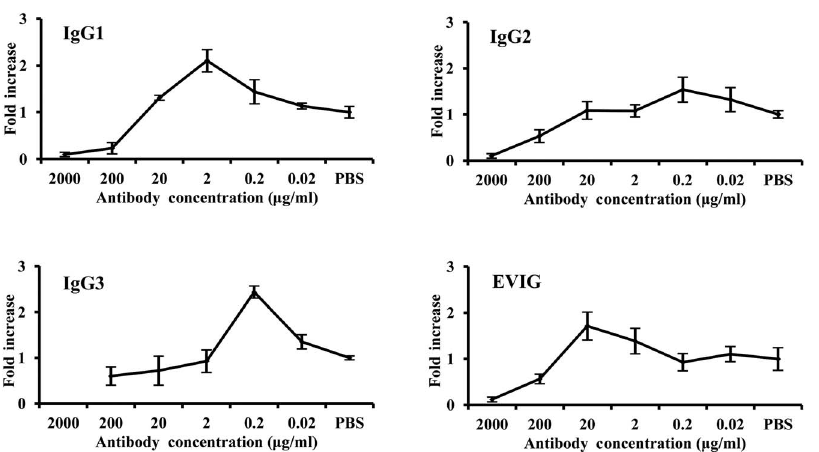
Figure 3. ADE profile of each human IgG subclass against EV71. Ten-fold dilutions of each IgG subclass and parent IVIG was incubated with EV71 strain AH08/06 at an MOI of 1 before incubation with human THP-1 cells, and the ADE potential was represented as fold increase of progeny viral titer compared with the PBS group.